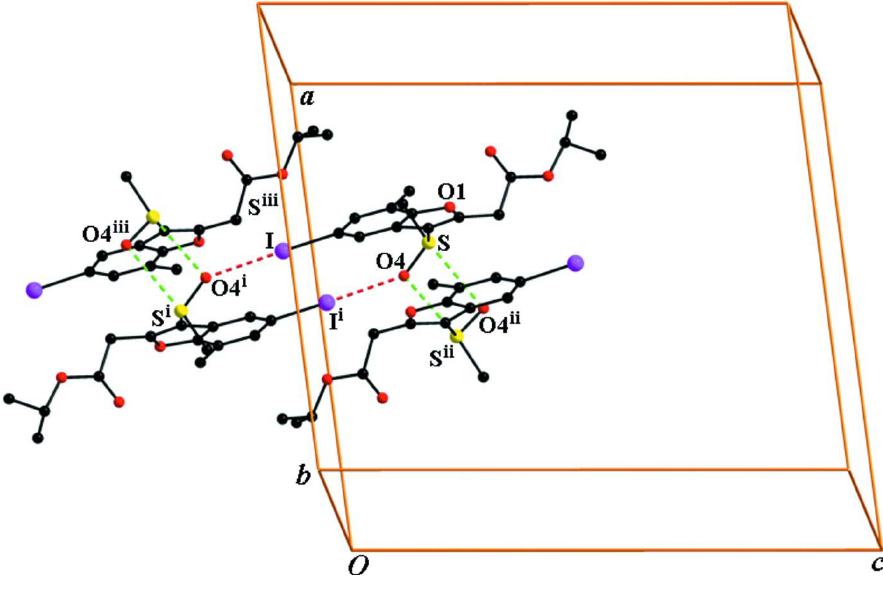
Figure 2 A portion of the crystal packing showing the I···O halogen bonding and S···O interactions by dotted lines [symmetry codes: (i) -x+1, -y+1, -z; (ii) -x+1, y, -z+1/2; (iii) x, -y+1,